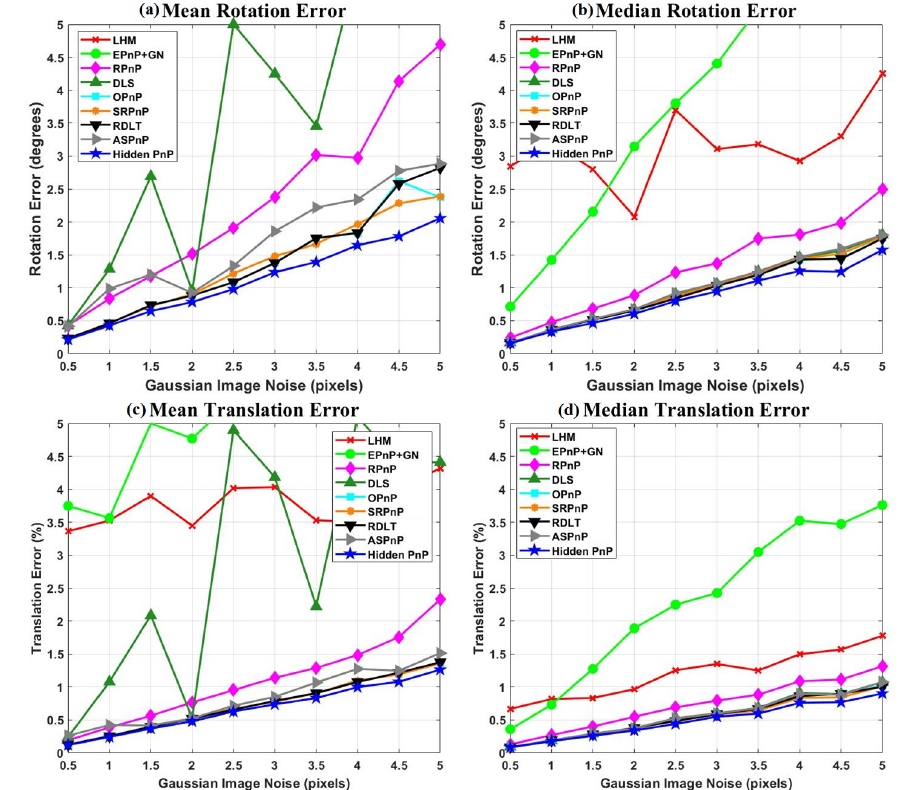
Figure 7. Error comparison in Planar case.